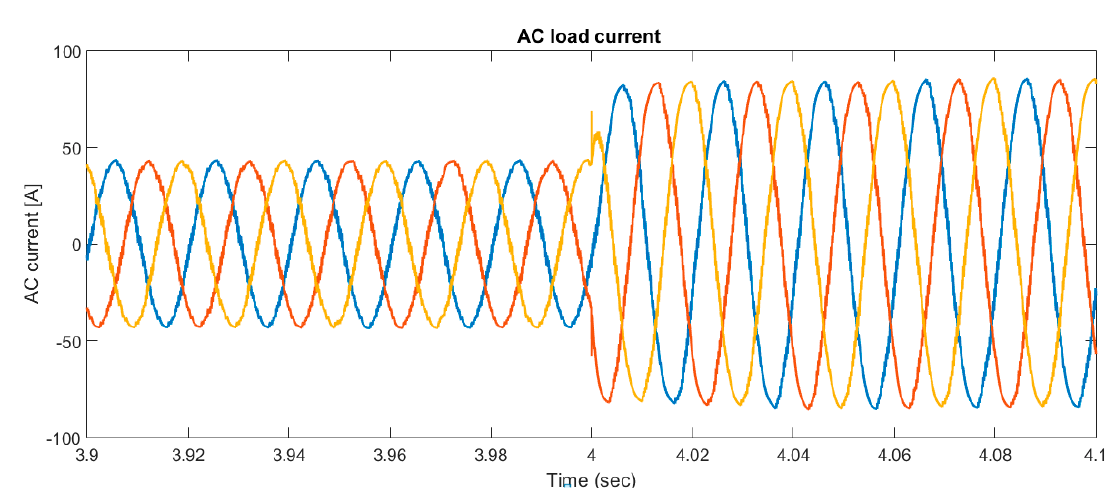
Figure 21. AC side charging current.